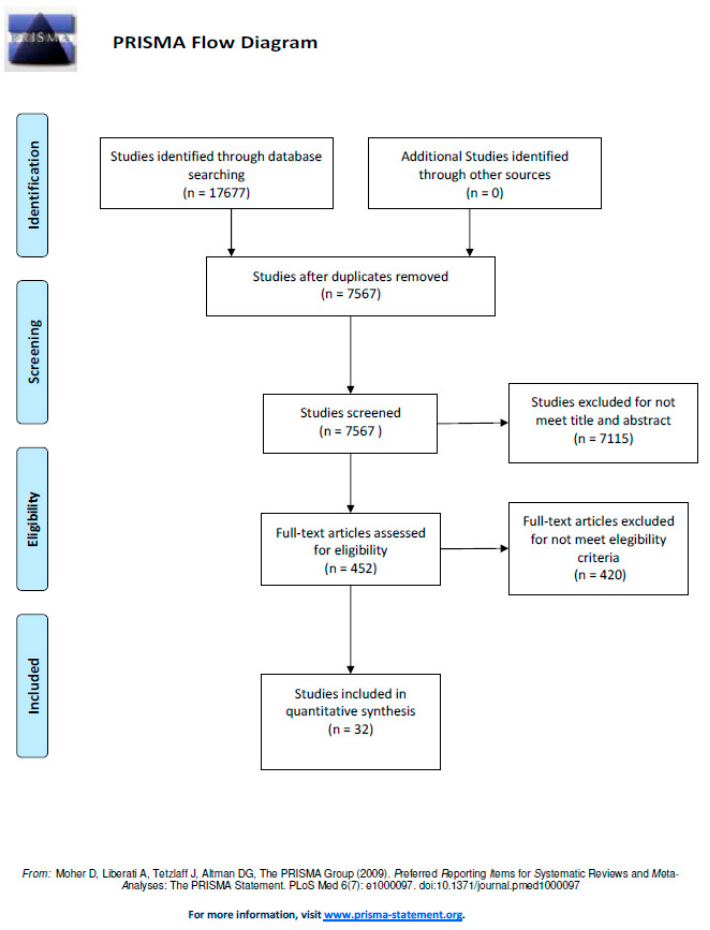
Figure 1. PRISMA Flow Diagram.